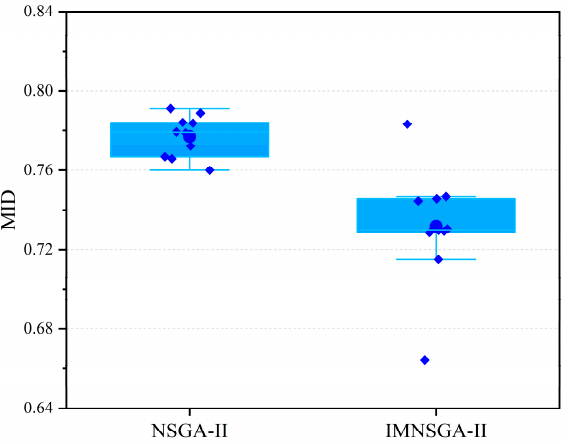
Figure 8. Comparison of results of evaluation metric between IMNSGA-II and NSGA-II.